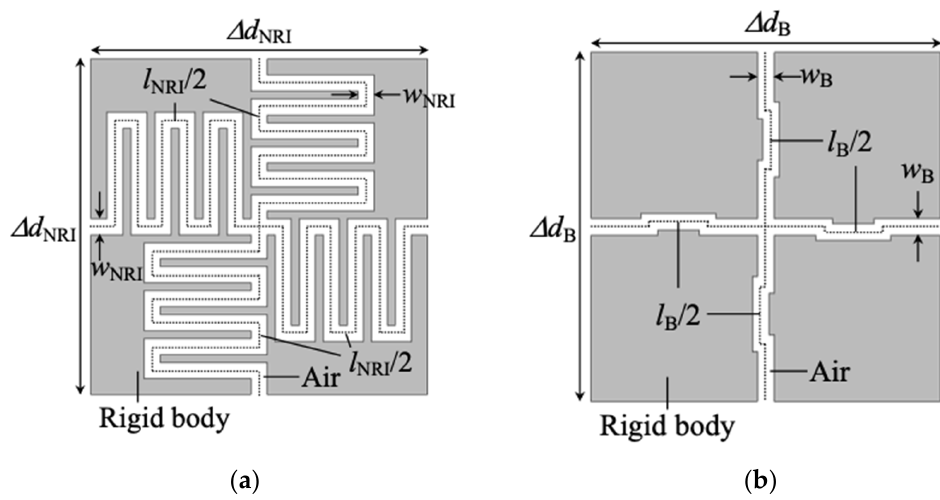
Figure 5. Modified unit cell structures. ( a ) For the NRI acoustic lens ( Δ d NRI = 25 mm, w NRI = 1.2 mm, and l NRI = 120.36 mm); ( b ) For the background medium ( Δ d B = 25 mm, w B = 1.2 mm, and l B = 26.47 mm). These refractive indices are set as n NRI = − 1.522 and n B = 1.522, respectively.